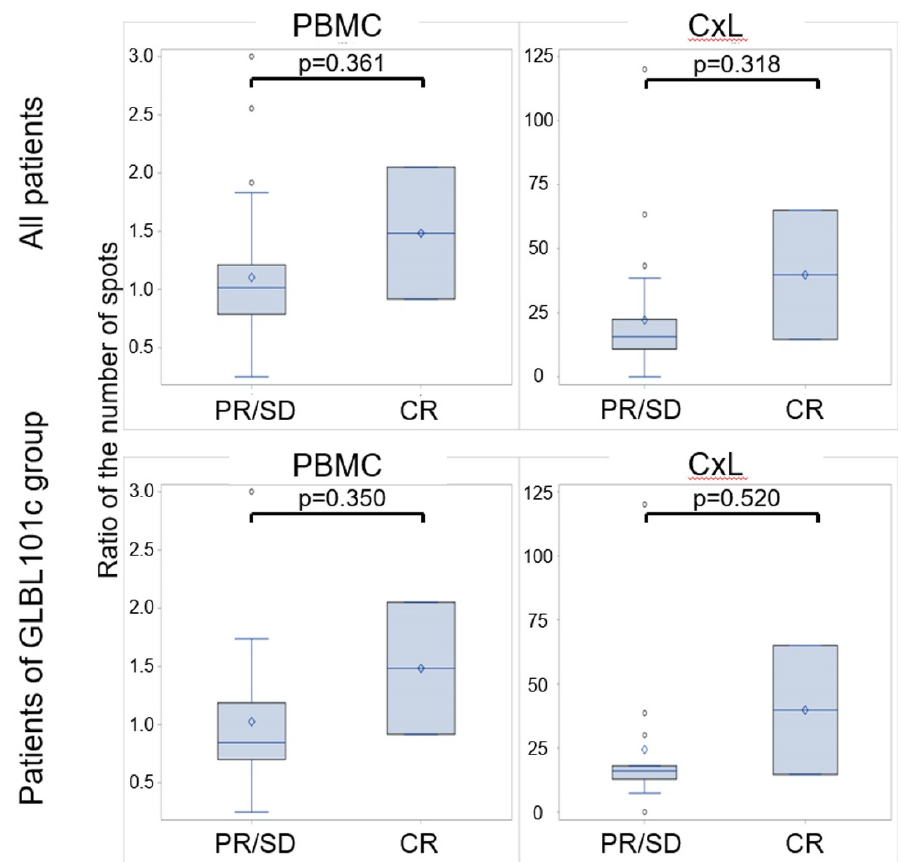
Figure 3. Ratio of the increase in the number of spots with to without E7 stimulation, comparing CR and PR/SD cases. The ratios for all patients (upper panels) or patients of GLBL101c group (lower panels) were plotted for PBMC (left panels) or CxL (right panels). Plot means each case. Box and bars mean 25–75% of all ratios and median and 1-SD, respectively. E7-specific Th1 immune response tended to be higher in CR patients in both PBMC and CxL when compared with PR/SD